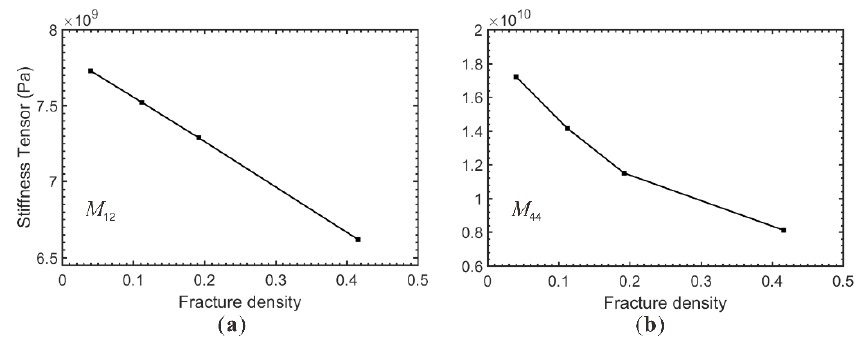
Figure 6. Effective stiffness tensors M 12 ( a ) and M 44 ( b ) for 3D fracture model.